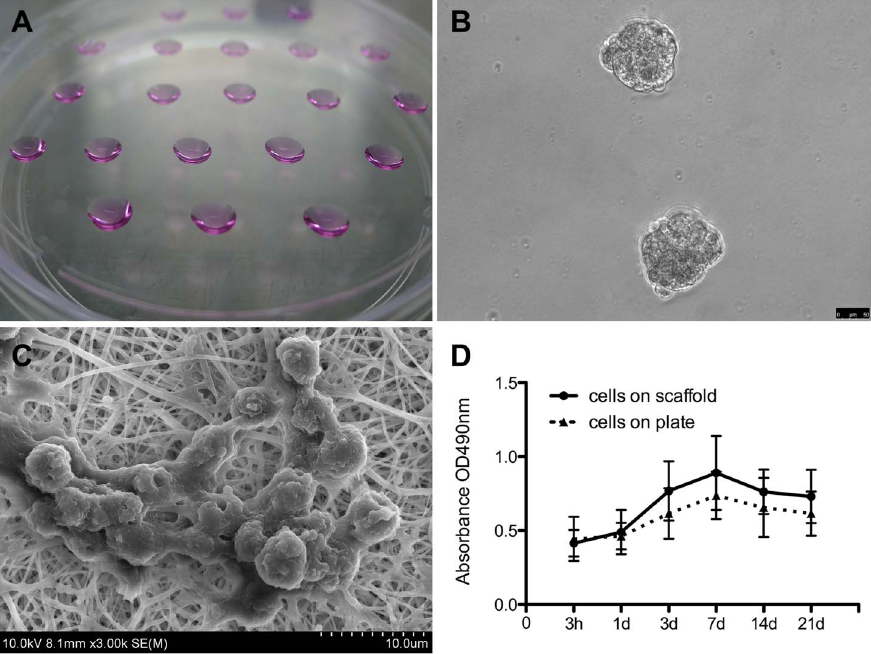
Figure 2. EB formation and the iPSC culture on the scaffold invitro . ( A ) Formation of EBs via serial dripping. Each drop of culture medium contained , 2 2 5 6 10 3 cells, which congregated and developed into an EB ( B ). ( C ) A cluster of iPSCs on the scaffold. ( D ) Proliferation of the iPSCs cultured on the scaffolds and on the plate was determined using CCK-8 tests; results revealed that the scaffolds promoted cell growth. doi:10.1371/journal.pone.0111566.g002 PLOS ONE |